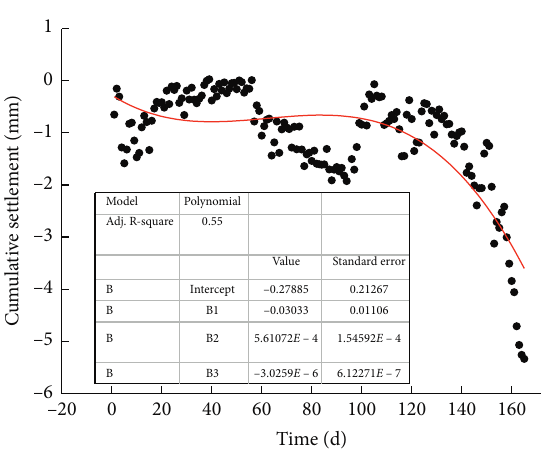
Figure 9: Data change curve fitting diagram. Table 7: Monitoring values of a measuring point in Junfeng Road Station during